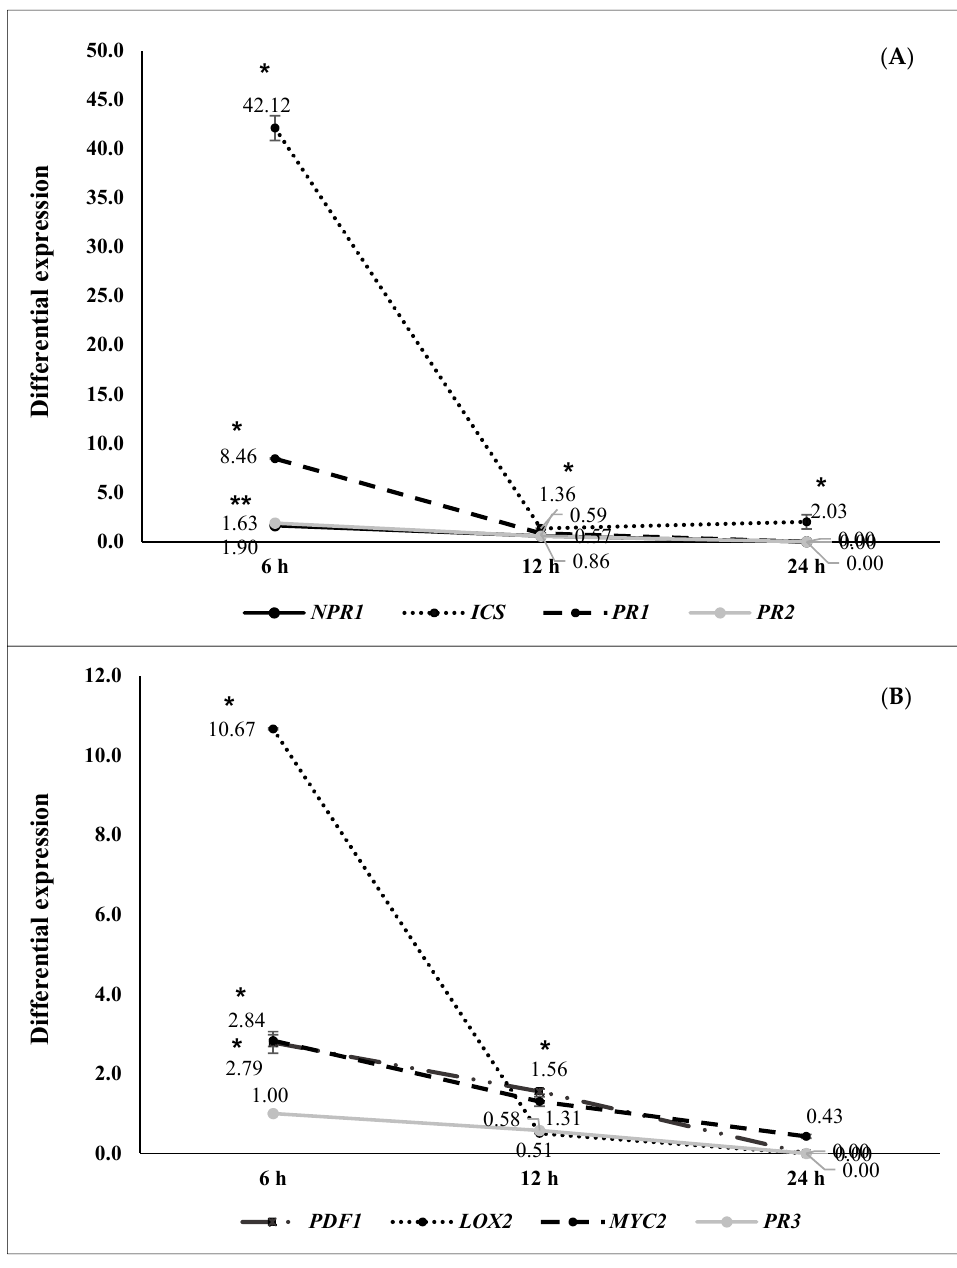
Figure 5. Differential gene expression (seedlings inoculated with N 21.24 ( Pseudomonas fluorescens ) vs negative control) at 6 ( n = 16), 12 ( n = 16) and 24 ( n = 16) hapc; ( A ) NPR1 , ICS , PR1, and PR2 genes (as SA signaling pathway markers) and ( B ) PDF1 , LOX2 , MYC2, and PR3 (as JA/ET signaling pathway markers). Asterisks represent statistically significant differences ( p < 0.05) with respect to negative control (differential expression of 1).